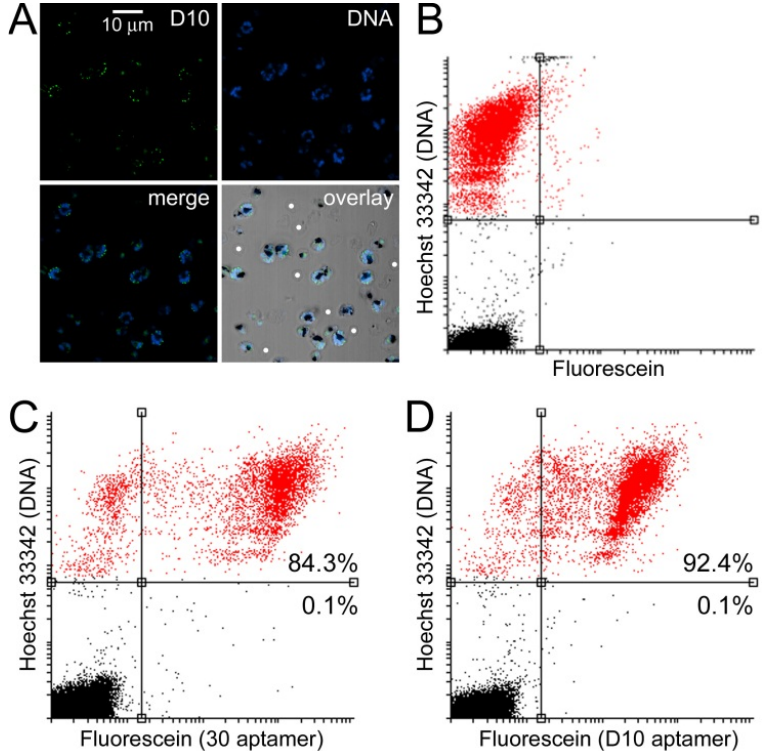
Figure 9. Comparison of the targeting to pRBCs of D10 and a previously described pRBC-specific aptamer. ( A ) Fluorescence confocal microscopy analysis of the specific targeting to pRBCs of 6FAM-labeled aptamer D10. White dots indicate some non-infected RBCs. ( B – D ) Flow cytometry analysis. ( B ) Hoechst 33342-only control. ( C ) Targeting analysis of 6FAM-labeled aptamer 30. ( D ) Targeting analysis of 6FAM-labeled aptamer D10. Percentages indicate the fraction of labeled cells relative to the total number of ( upper panels ) pRBCs and ( lower panels ) non-infected RBCs.